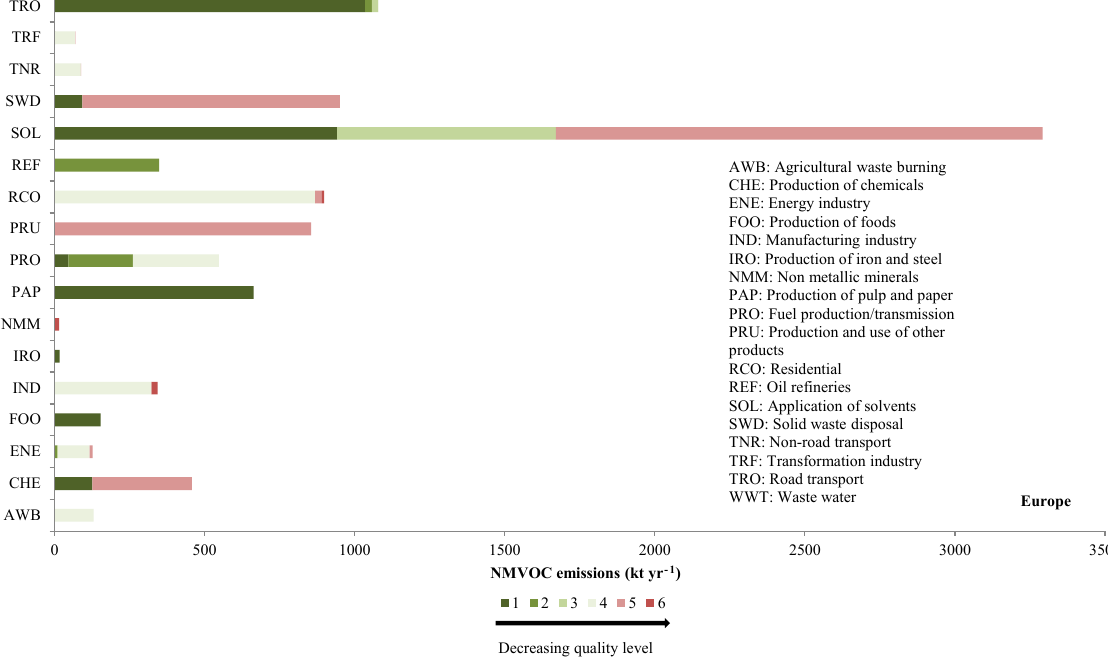
Figure 8. NMVOC emissions of different sources associated with each quality code in 2010 in